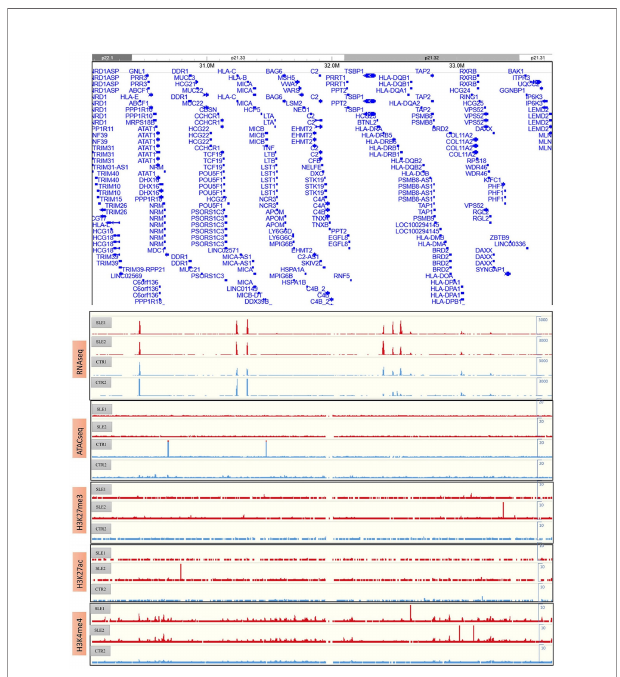
FIGURE 5 | The results of RNA-seq, ATAC-seq and ChIP-seq of H3K27me3, H3K27ac and H3K4me4 around HLA complex